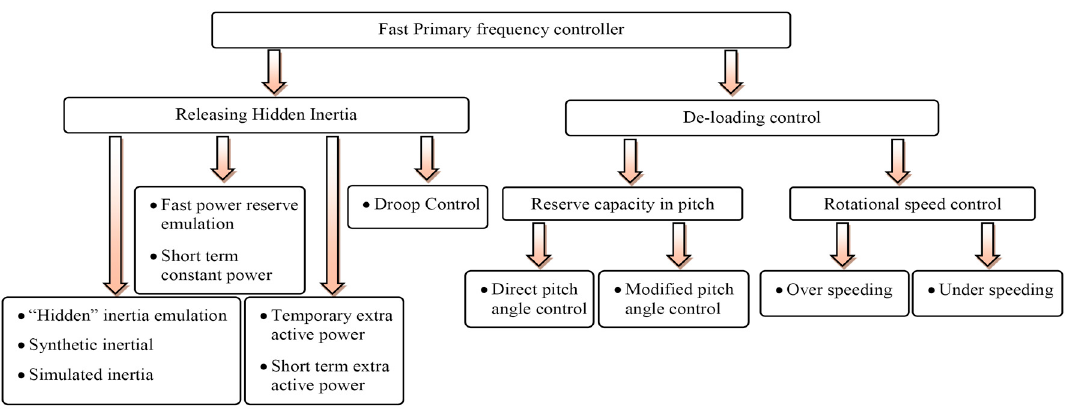
Figure 1. Classification of control strategies.